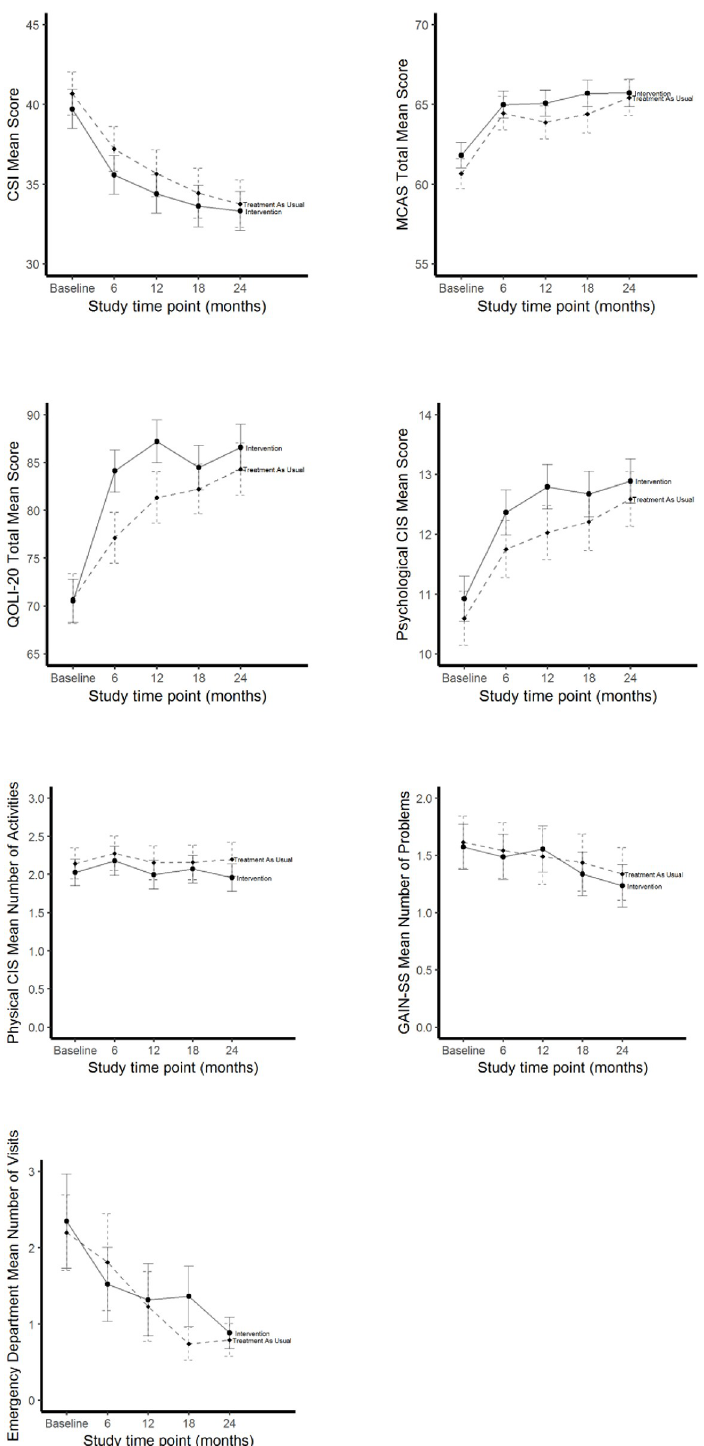
Fig 1. Health and social outcomes among women who are homeless and mentally ill, unadjusted means and 95% confidence intervals over 24 months of follow-up by study time point and treatment group. Note . N = 653. CSI = Colorado Symptom Index; MCAS = Multnomah Community Ability Scale; Lehman Quality of Life Interview 20 = QoLI-20; CIS = Community Integration Scale; GAIN-SS = Global Assessment of Individual Needs Short